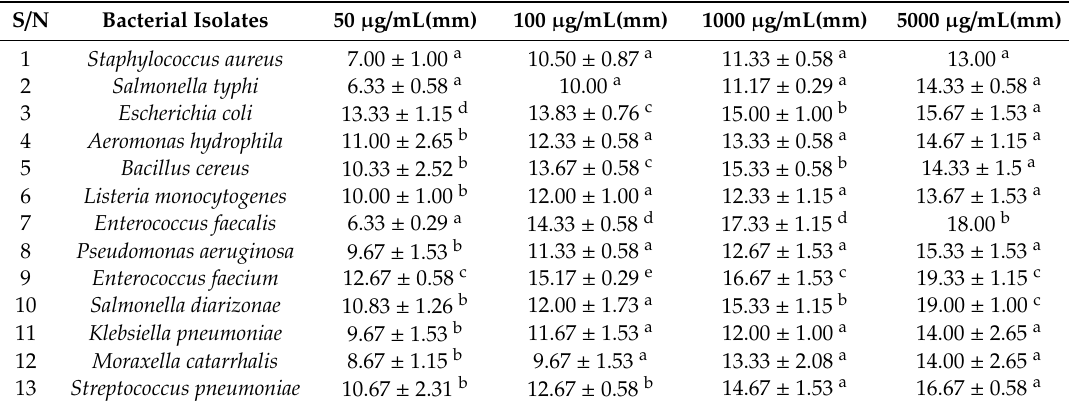
Figure 11. Plates showing the zones of inhibition obtained upon testing biosynthesized nanoparticles against bacterial strains. Table 3. Mean zones of inhibition value (mm) produced by zinc oxide nanoparticles mediated via pomegranate ( Punica granatum ) leaf